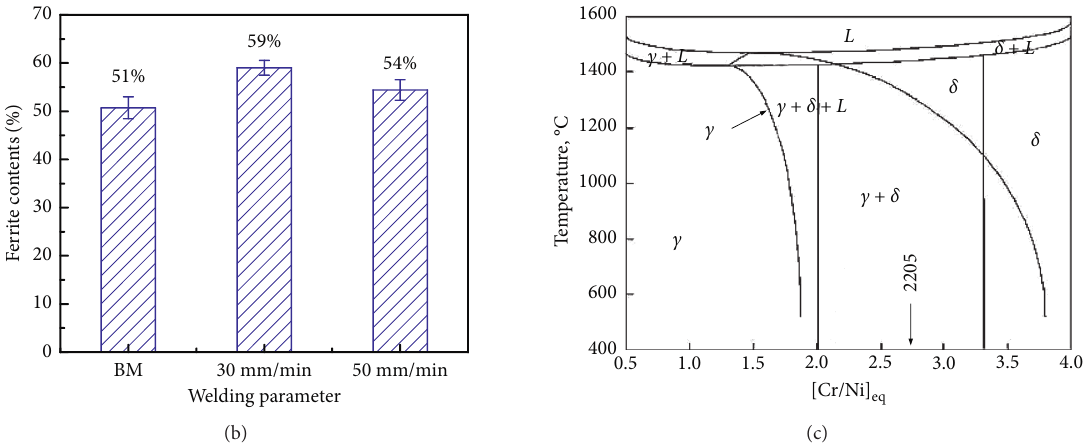
Figure 5: Phase composition results of the base material and stir zones at different welding speeds: (a) X-ray diffraction patterns of stir zones, (b) ferrite contents in base material and stir zones, and (c) phase diagram for 2205